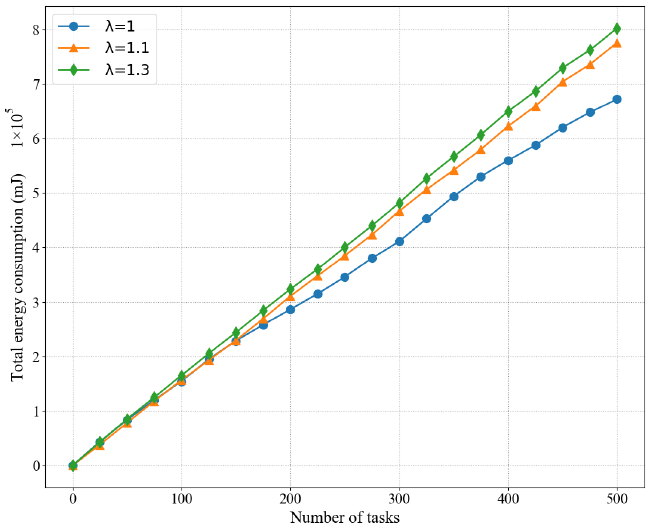
Figure 6. Influence of different arrival rates on the average energy consumption of the LPSO algo- rithm.